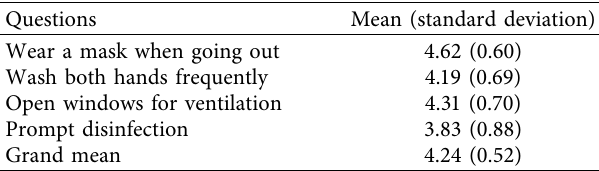
Table 4: COVID-19 preventive behaviors of the